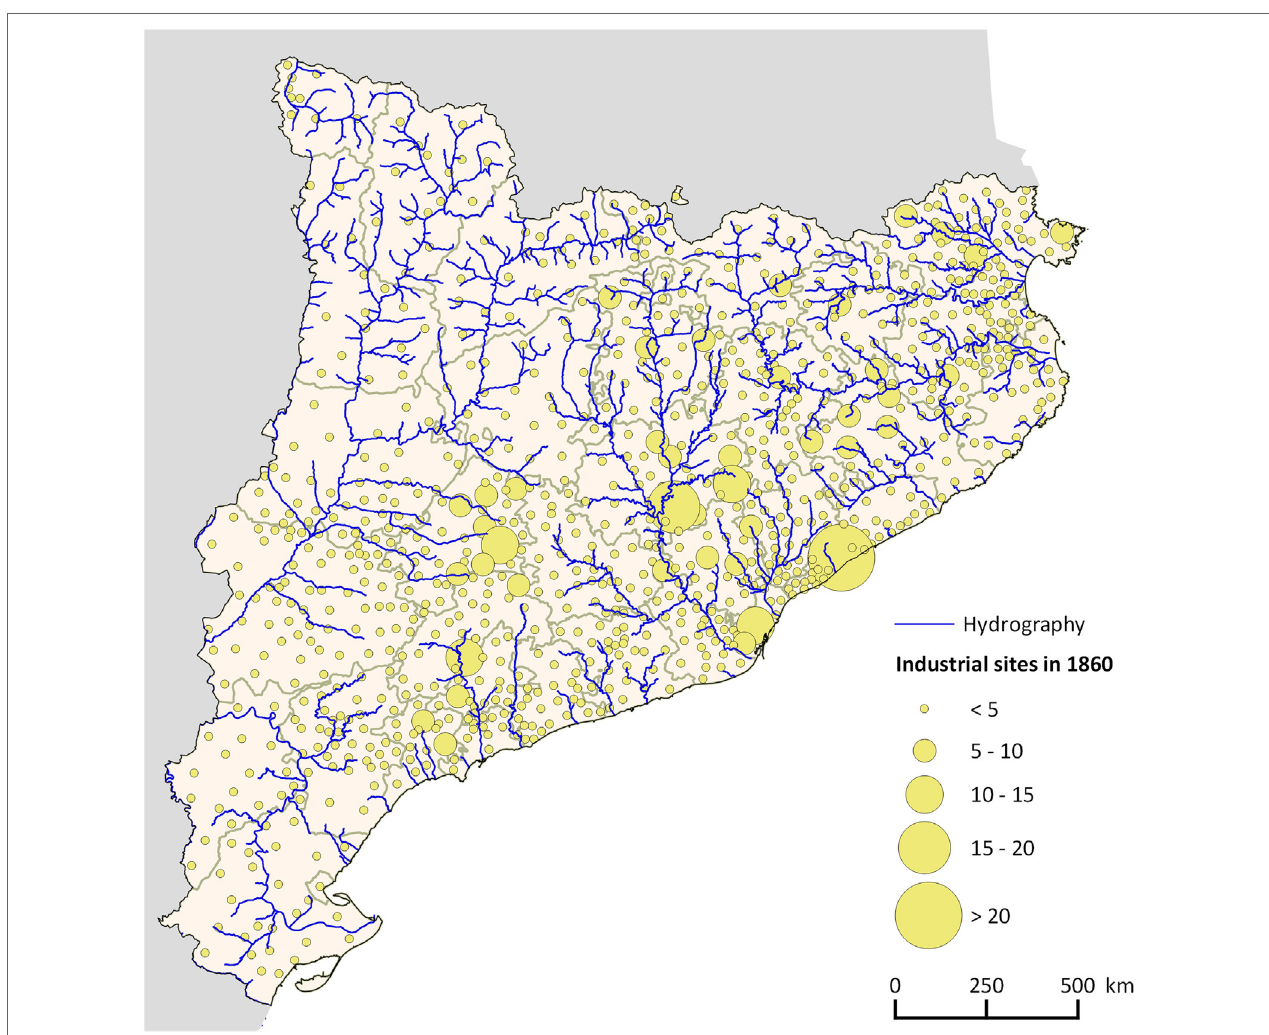
FigUre 10 | Heritage sites and rivers in Catalonia in 1860. Source: Own